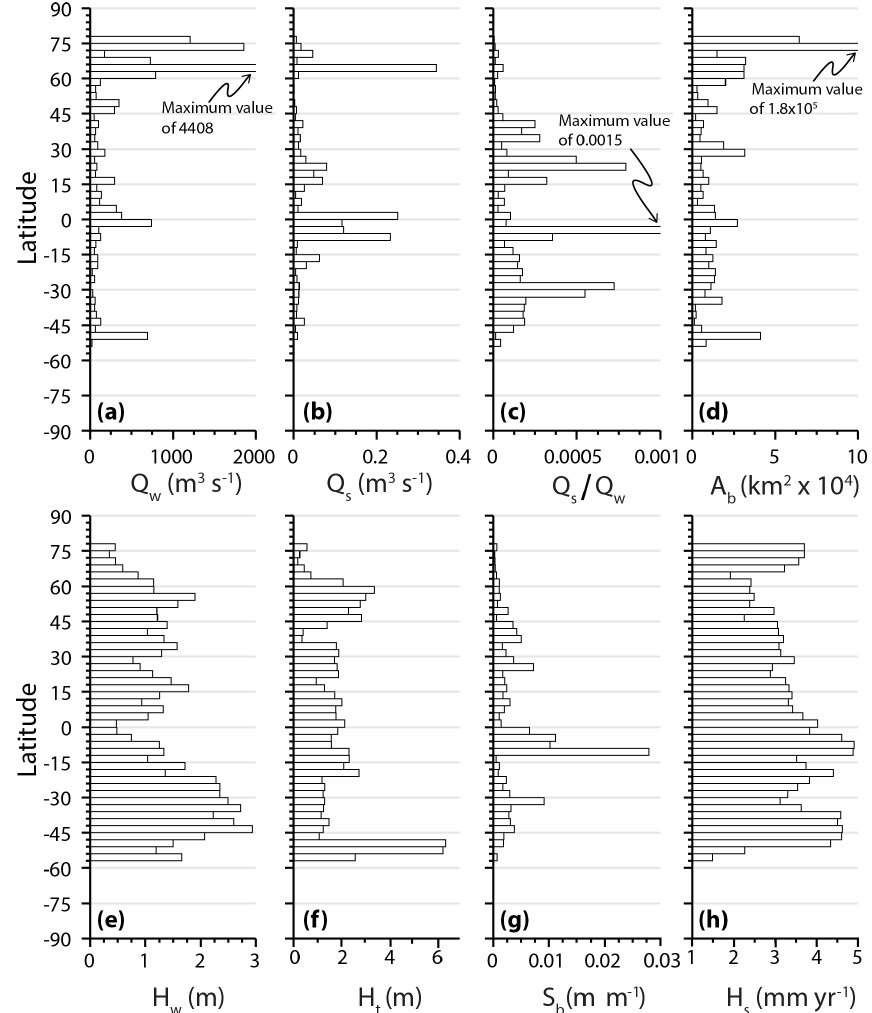
Figure 4. Latitudinal variation of the independent variables used in this study. All panels show the median value for 3 ◦ bins: (a) water discharge, Q w ; (b) sediment discharge, Q s ; (c) sediment concentration, Q s /Q w ; (d) drainage basin area, A b ; (e) mean annual significant wave height, H w ; (f) median tidal range, H t ; (g) bathymetric slope, S b ; (h) rate of sea level change, H s . For (a, c, d) the outliers have been cut off for viewing